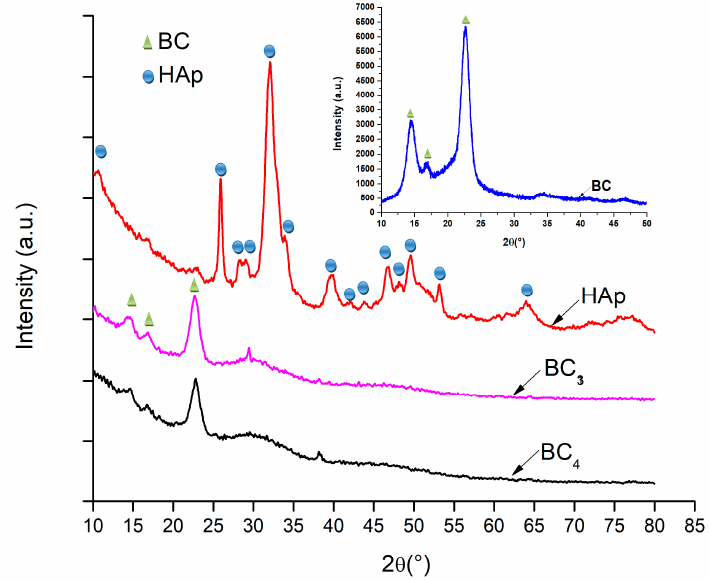
Figure 5. XRD analysis corresponding to the composites samples BC 3 and BC 4, and hydroxyapatite (HAp) obtained by the coprecipitation method.